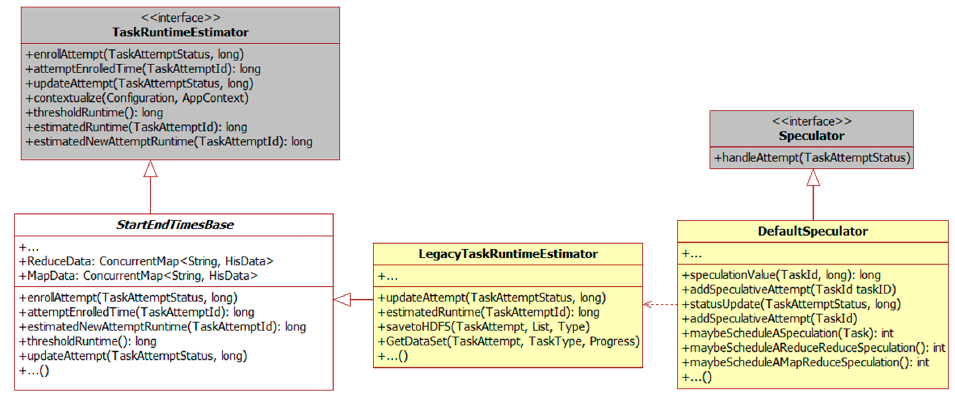
Figure 1. Implementation detail.